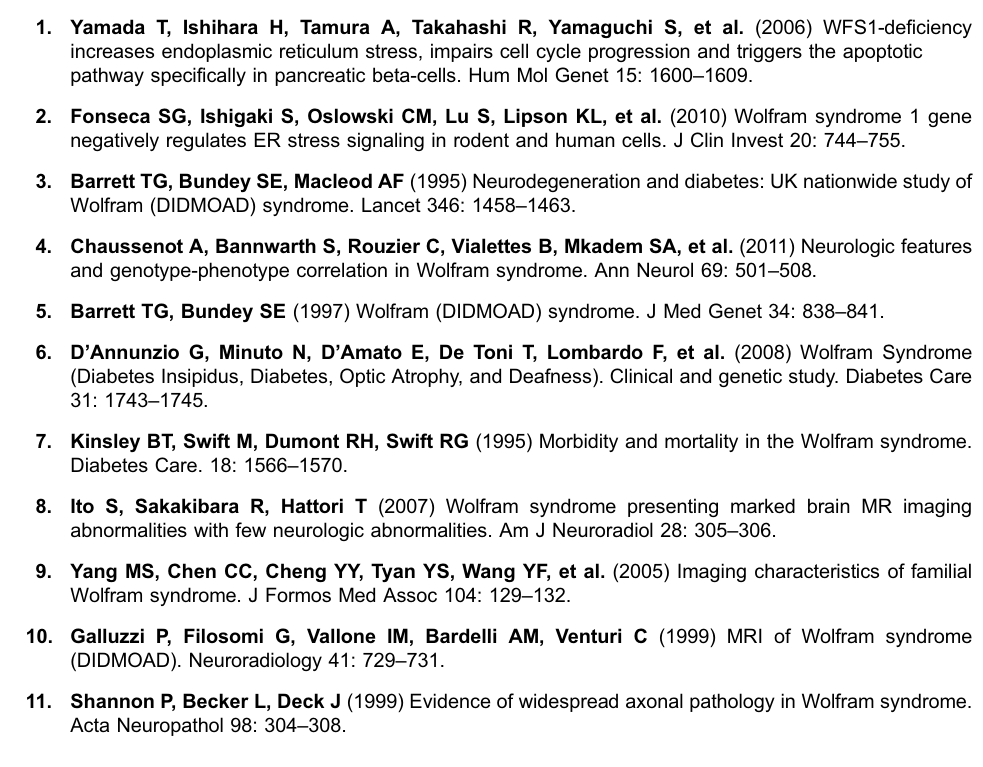
S1 Table. Mean SUVs for all brain regions in patients with WFS and a control group (nonstandardized data; L, left side of the brain; R, right side of the brain). Regions with differences significant in unadjusted comparisons are marked in